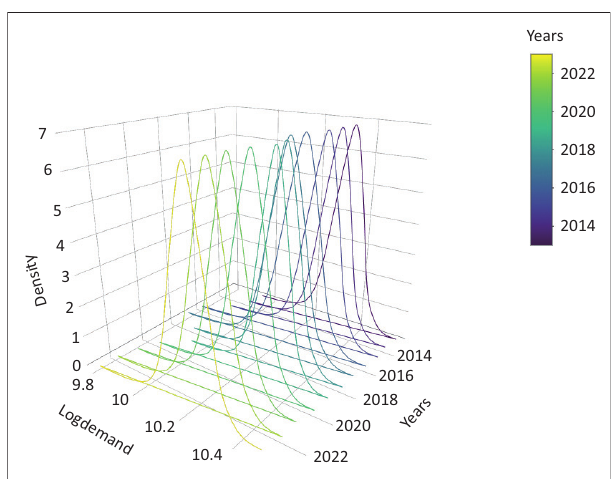
FIGURE 9: The afternoon peak demand